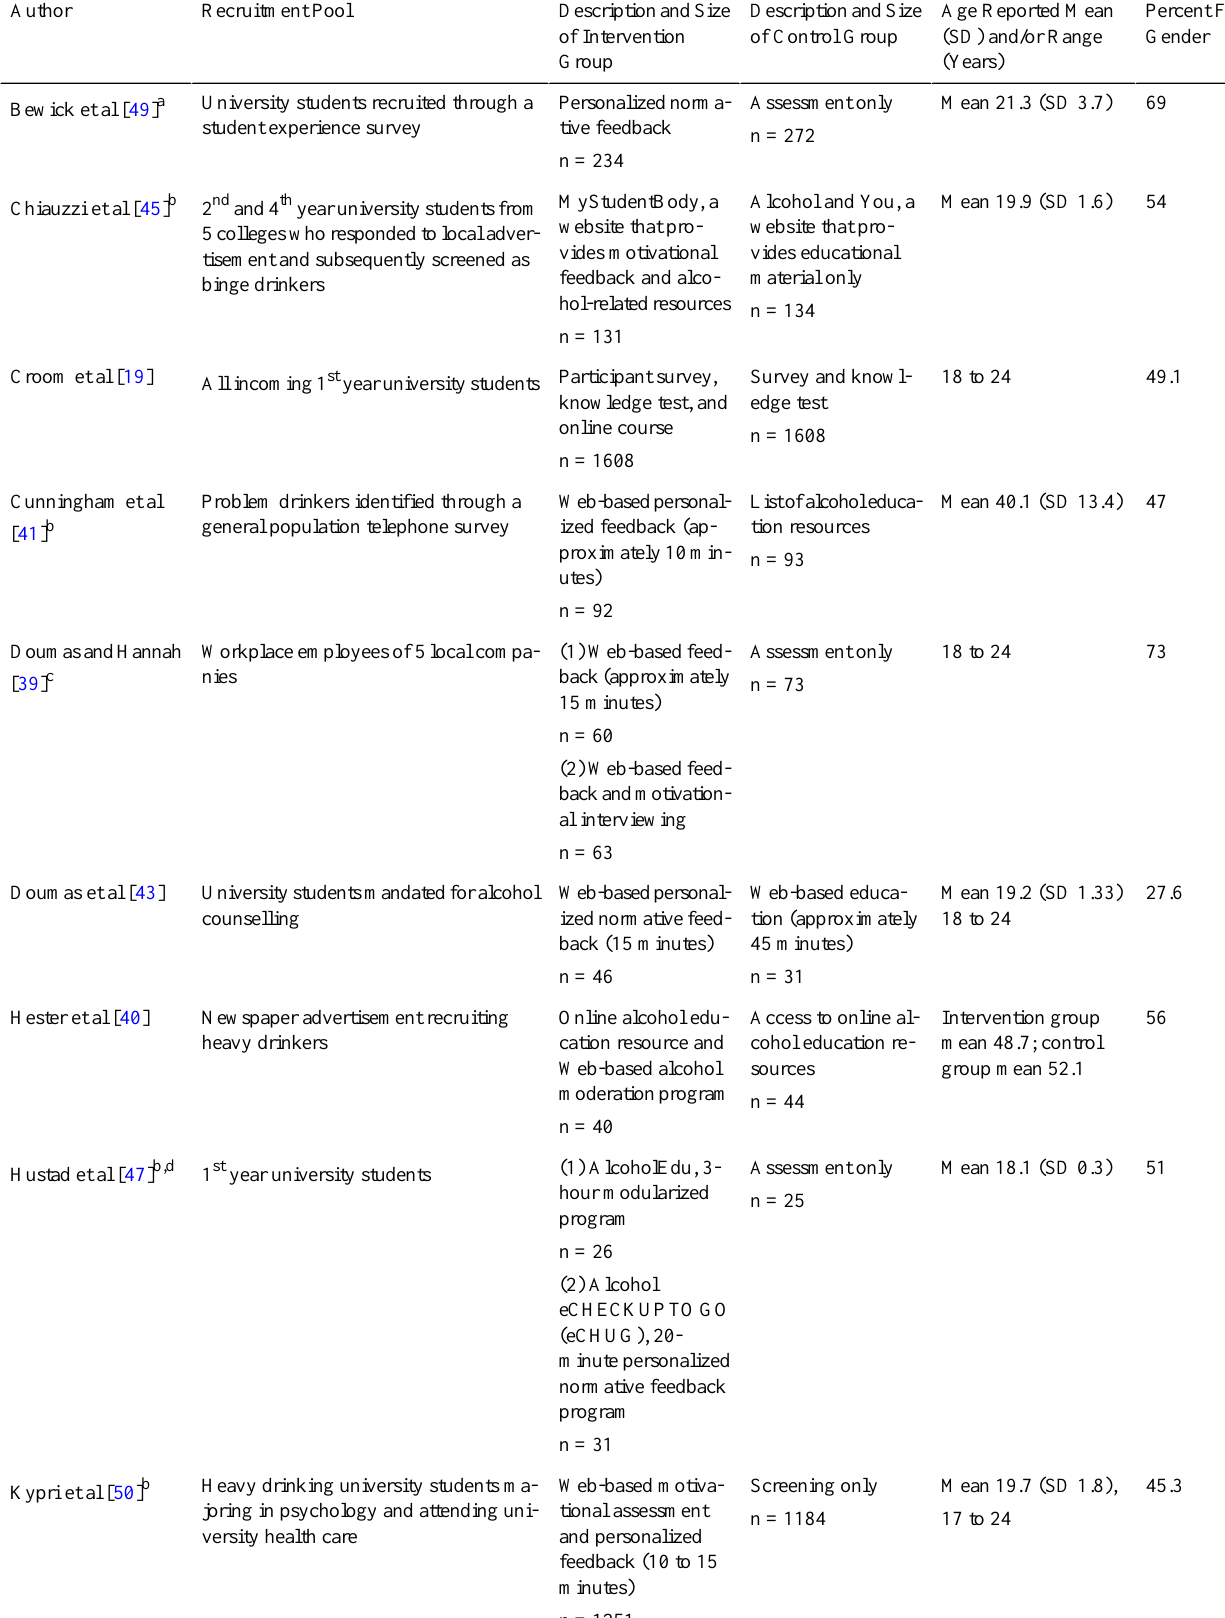
Table 1. Characteristics of online alcohol-related randomized controlled trials